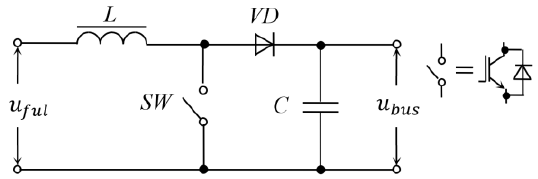
Figure 12. DC -to- DC boost converter chart.